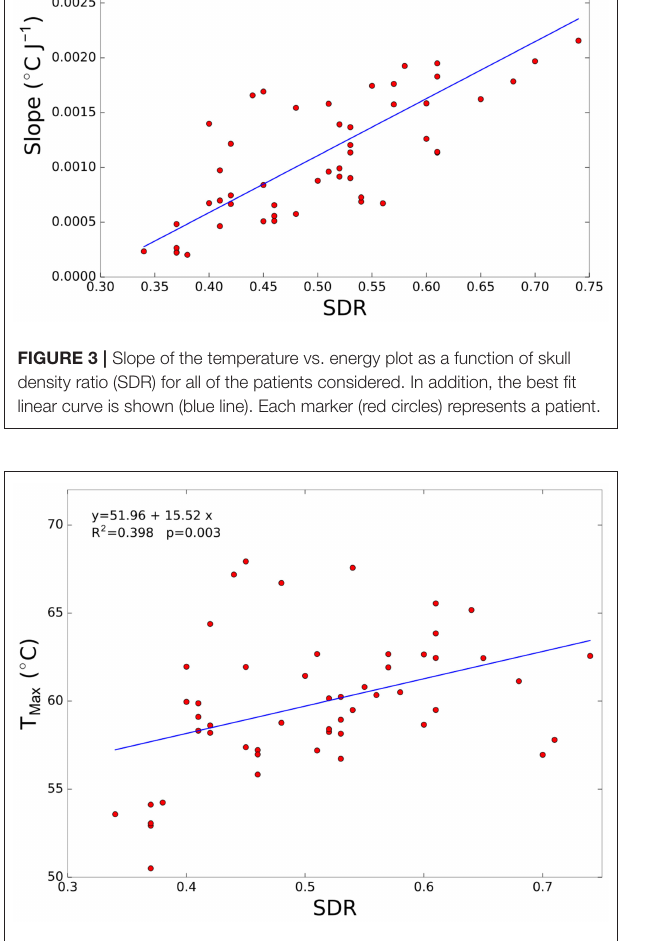
FIGURE 4 | Maximum peak temperature (Tmax) as a function of skull density ratio (SDR) for all enrolled patients. In addition, the best fit linear curve is shown.